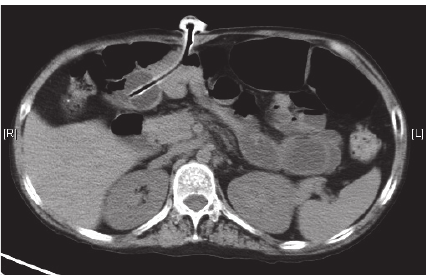
Figure 1: Computer topography of the abdomen showing the PEG tube extending over the right in the abdominal cavity and the opening in close proximity to the